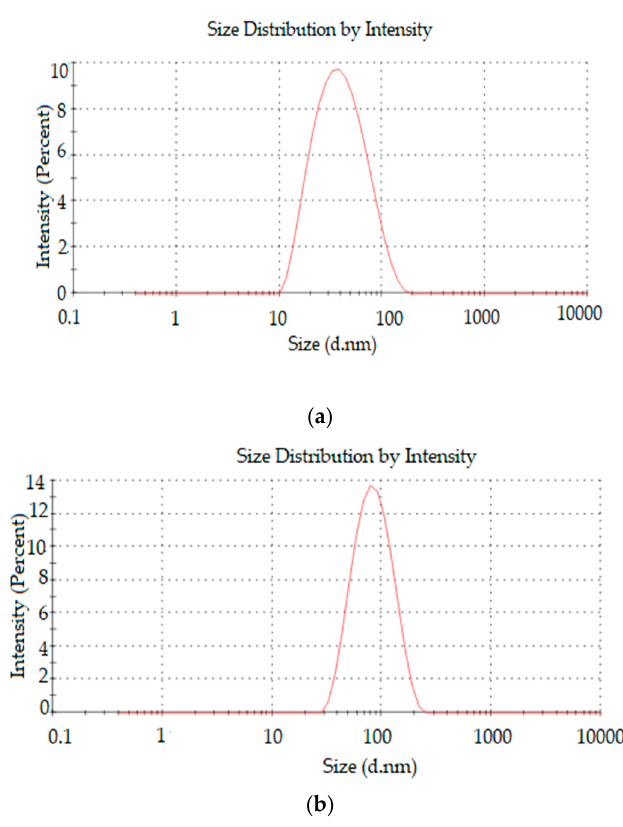
Figure 5. The particle size distribution of ( a ) F30 and ( b ) F85 by dynamic light scattering (DLS).